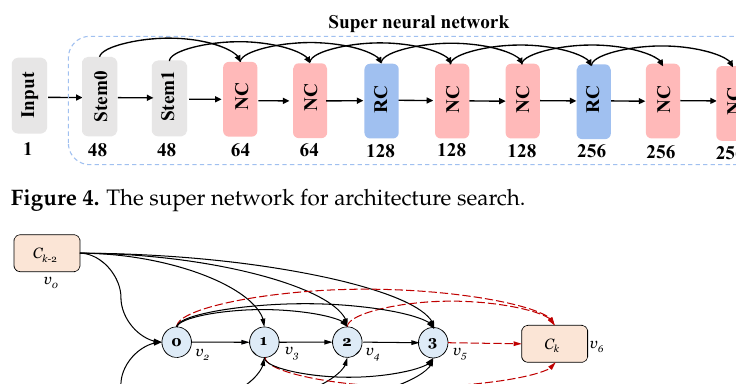
Figure 3. The composition of backbone.